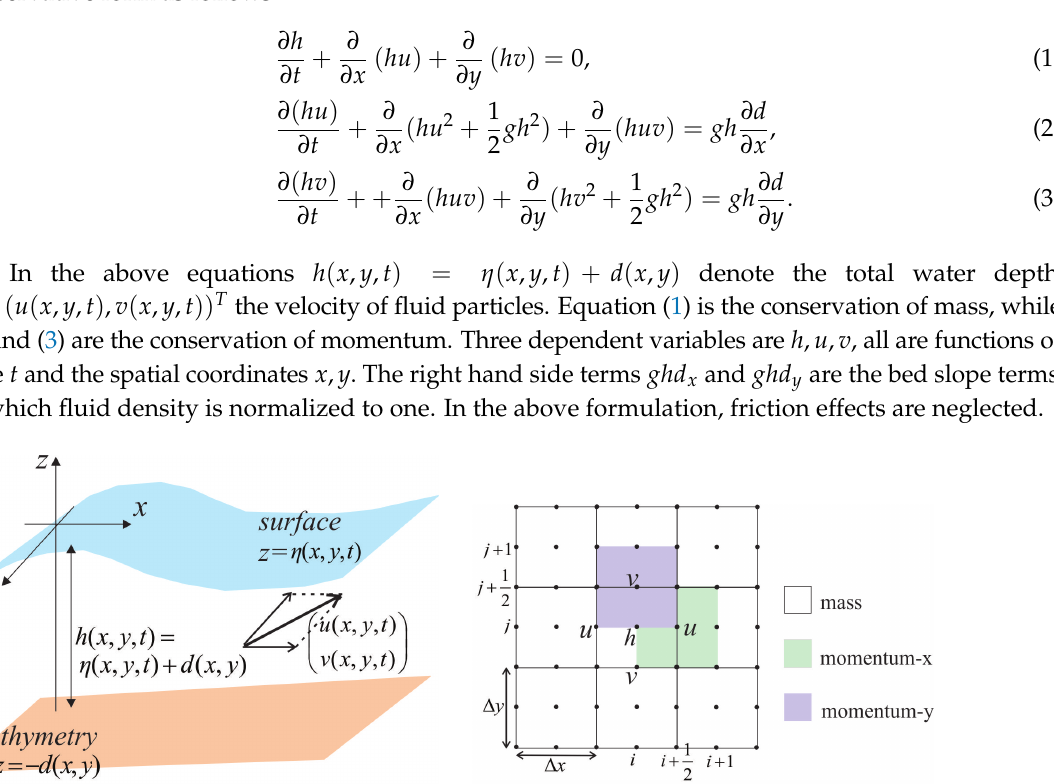
Figure 1. ( Left ) Sketch of the fluid domain and notations. ( Right ) Arakawa-C grid with illustrations for mass and momentum